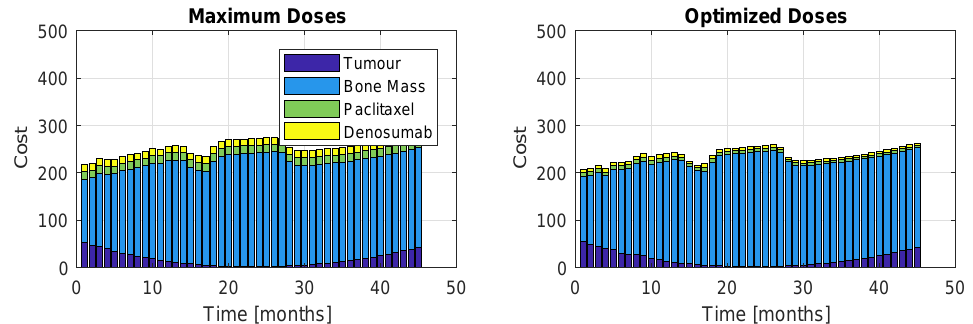
Figure 16. Proportions of the four cost contributions/terms in the objective function: Tumour, Bone Mass, Paclitaxel and PI (Model M DR 2 , Therapy T 4 + T 3 ). The right plot represents the cost resultant from optimization, while the left represents the cost if the maximum dose was administrated.